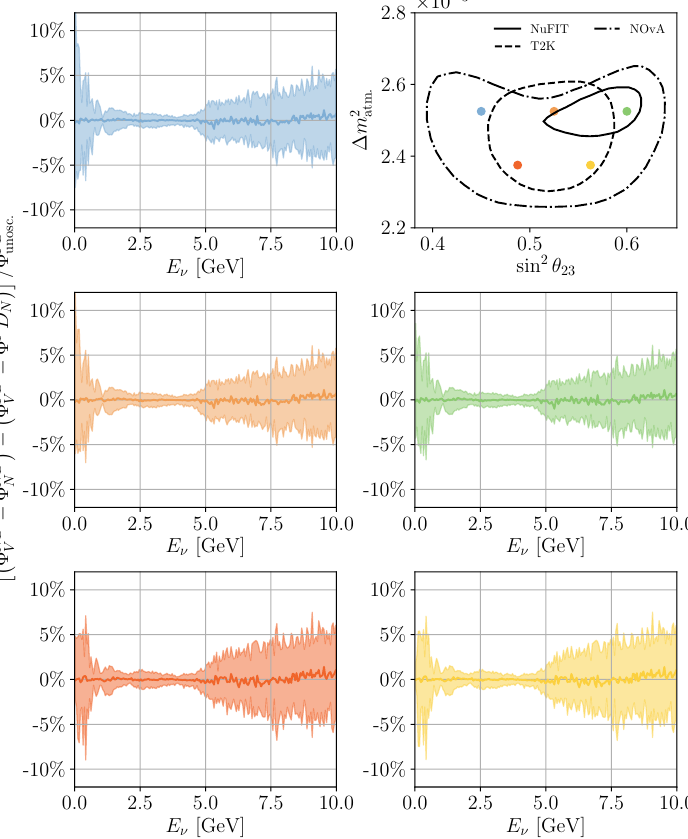
Figure 111. Cancellation of hadron production systematic variations assuming various oscillation hypotheses (top right). Shown are median values (solid line) and 68% containment intervals (bands). The figure colors correspond to the oscillation hypothesis points on the upper right